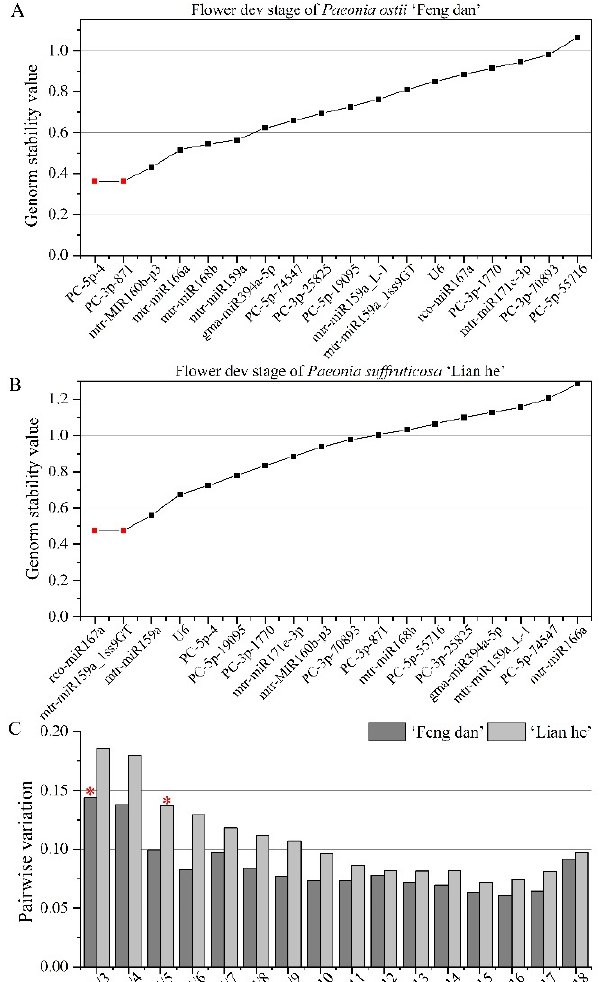
Figure 7. Expression stability analysis and pairwise variation (Vn/Vn+1) analysis of candidate reference miRNAs in flower development stage calculated by geNorm. Expression stability results are shown in ( A ) ( Paeonia ostii ‘Feng dan’) and ( B ) ( Paeonia suffruticosa ‘Lian he’) of Figure 7. The most stable miRNA is shown on the left and the least stable miRNA is shown on the right. The red ‘ (cid:4) ’ represents suitable miRNAs. The results of pairwise variation analysis are shown in ( C ). The red ‘*’ represents suitable quantity.